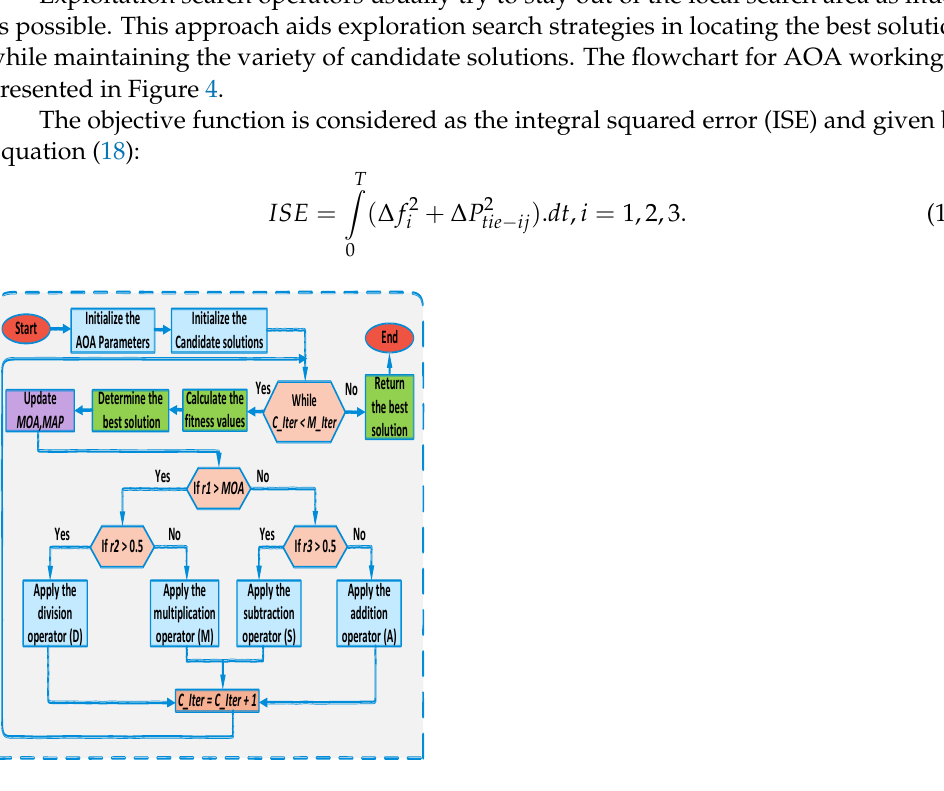
Figure 4. Flowchart for arithmetic optimization